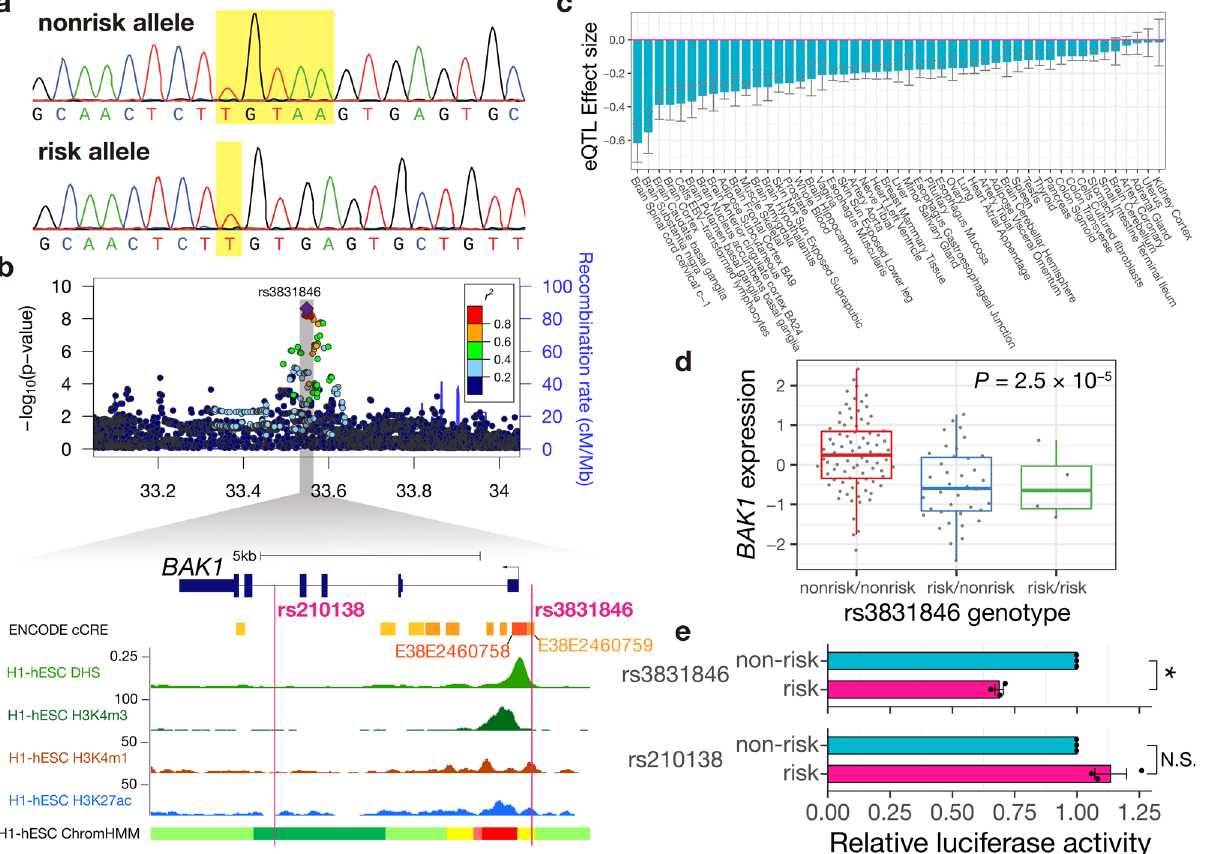
Fig.2|Functionalcharacterizationofthe fi ne-mappeddeletionpolymorphism rs3831846. a The deletion polymorphism rs3831846 was validated by Sanger sequencing. The polymorphic site is highlighted in yellow. b Regional plot